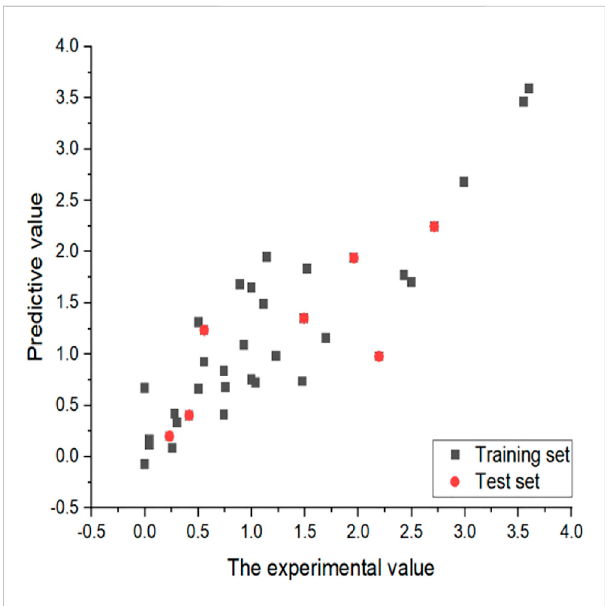
FIGURE 4 Plots of measured and calculated log(IC 50 ) by